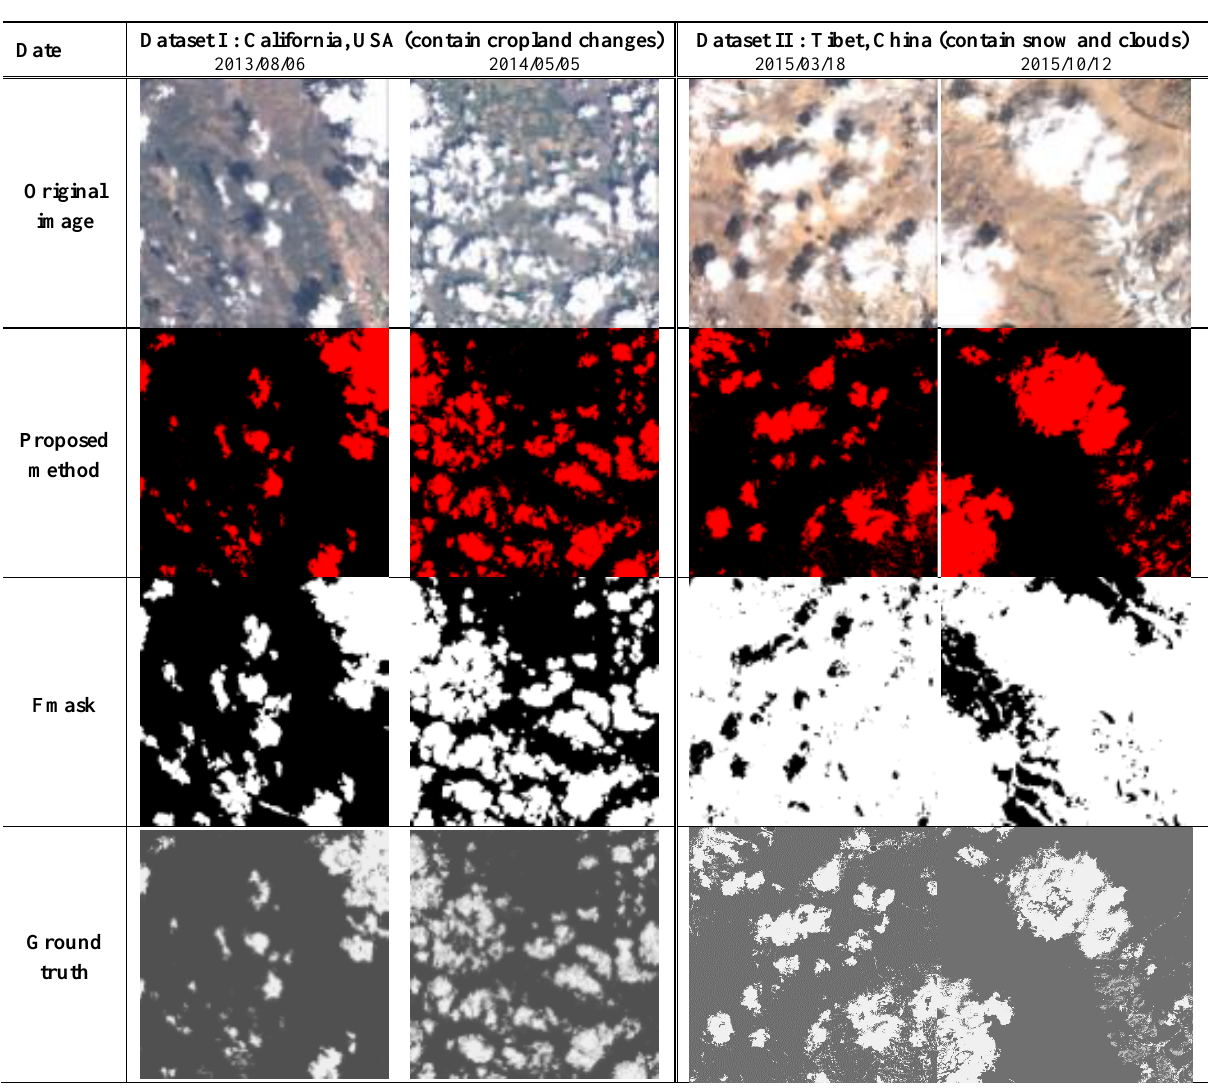
Figure 7 . Cloud detection results in dataset I and dataset II.